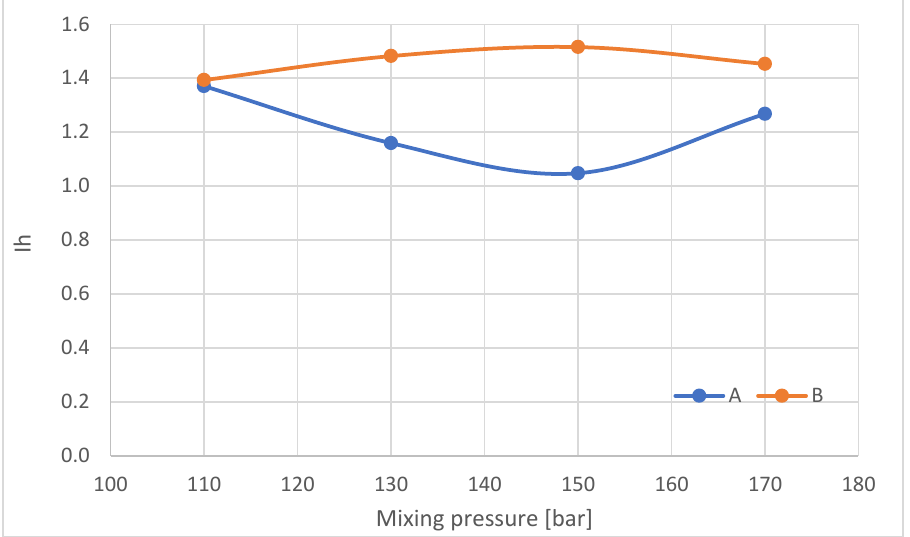
Figure 18. Share of hydrogen bonds connecting the rigid foam segments (Ih).